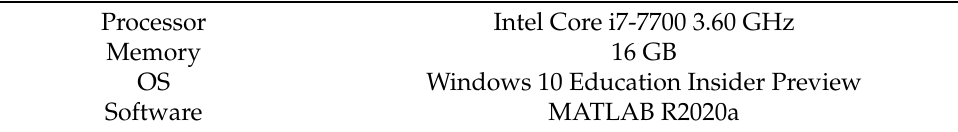
Table 6. Machine spec used for evaluating executing